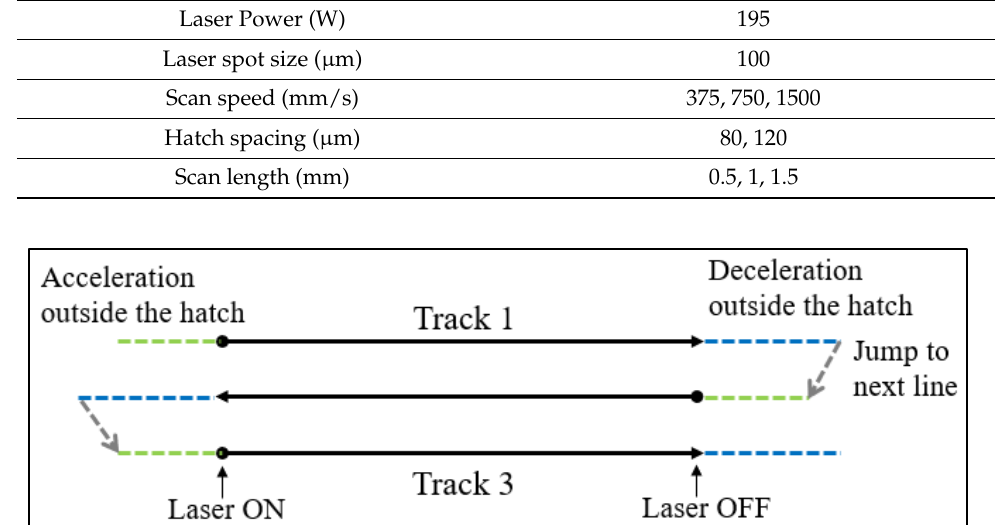
Figure 1. Schematic of the constant energy input in the scan lines during raster scanning.